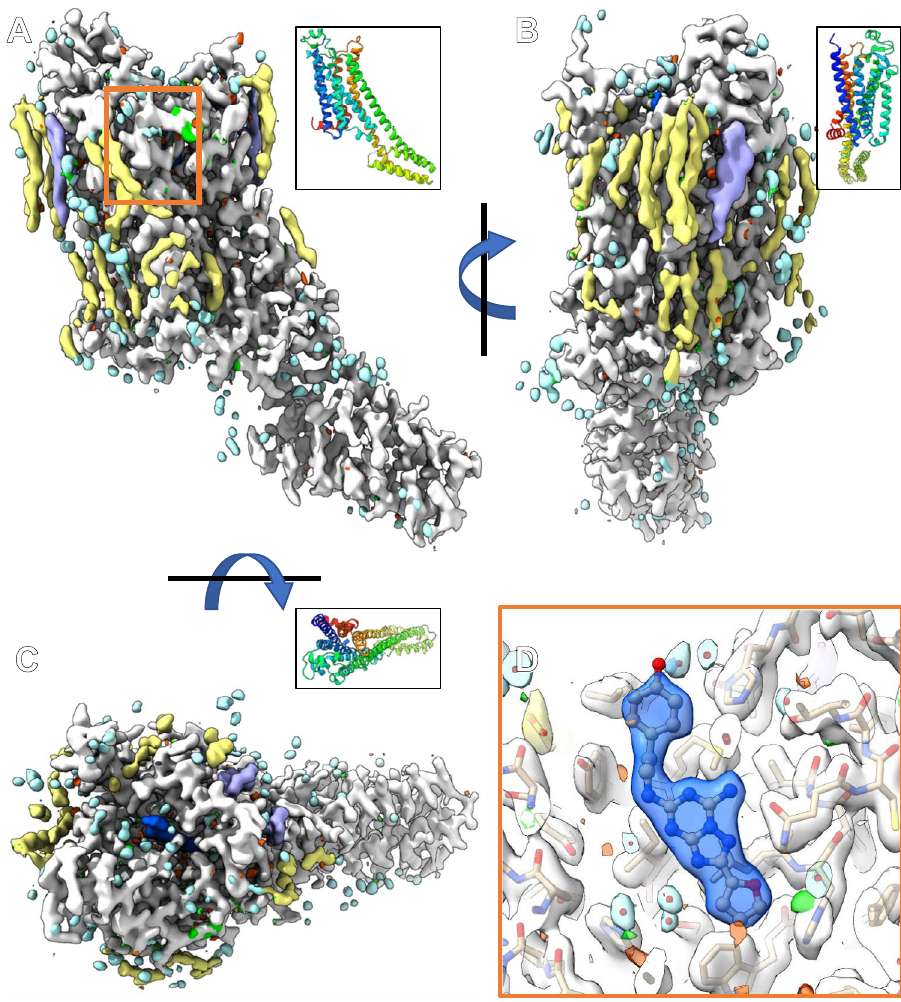
Fig.7|The2.0ÅMicroEDstructureofA 2A ARfrommicrocrystalsburiedinthick LCP. A – C Showing the fi nal 2mFo-DFc density and mFo-DFc difference maps contoured at 1 σ and ±3 σ at various orientations. The corresponding ribbon dia- gram isshowing in rainbowin the top right corner foreachdensity. D The binding pocket showing the density and difference densities around the bound antagonist